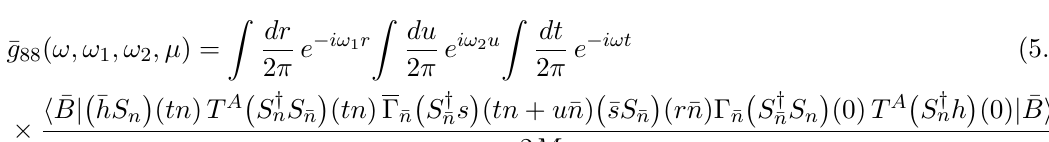
Figure 7 . The cut diagram arising from the matching of the (left) and onto HQET (right). Red indicates soft (cid:12)elds, black (anti-) hard-collinear (cid:12)elds. Hard (cid:12)elds are already integrated out. Dashed lines correspond to